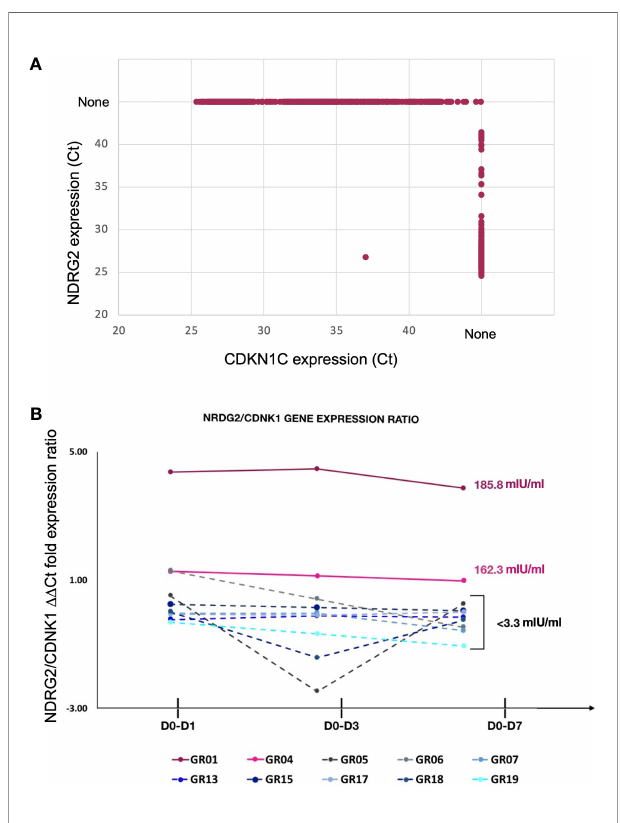
FIGURE 4 | Relative proportion of mDC subsets expressing NDRG2 and CDKN1CC are correlate with HBV vaccine response – (A) Ct values from qPCR reactions measuring expression of NDRG2 and CDKN1C for 964 single mDC cells expressing at least one marker are plotted, showing mutually exclusive expression of NDRG2 and CDKN1C in sorted mDCs. None indicates no ampli fi cation. (B) Single myeloid dendritic cells were sorted from blood collected prior to HBV vaccination (D0) and 1 day (D1), 3 days (D3) and 7 days (D7) post vaccination. Following cDNA preparation, the expression of NDRG2 (mDC2 expressing gene) and CDKN1C1 (mDC4 expressing genes) mRNAs were quanti fi ed by qPCR. The graph shows the change in the relative proportion of NDRG2-expressing mDC2s/CDKN1C-expressing mDC4s at each time point compared to D0 per study participants. Solid lines show the HBV dose 1 responders (with anti-HBV titres higher than 10 mIU/ml at Day 28 after fi rst dose and titers indicated next to the lines). Dotted lines show the HBV dose 1 non-responders (less than 10 mIU/ml HBV titers) after the fi rst dose of vaccine. Each line shows values of individual participants; the Y axis values were log transformed. Raw data is provided in Supplementary Tables 5 and 6